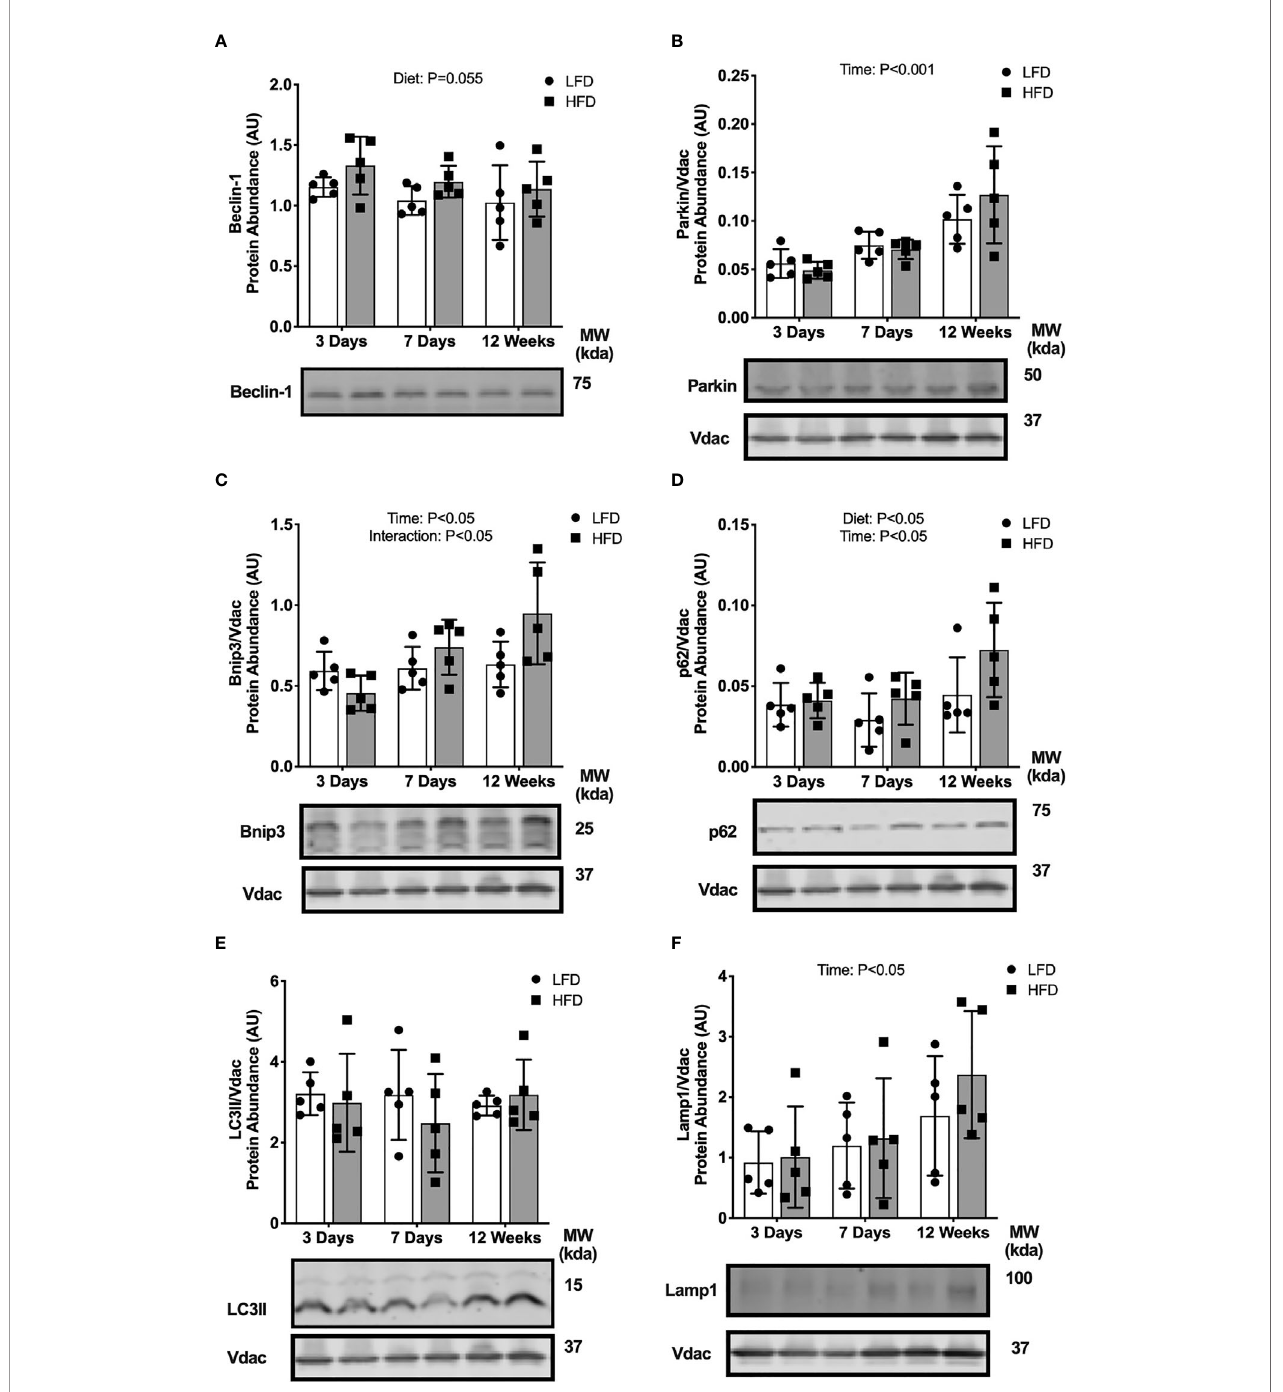
FIGURE 3 | Short-term high-fat feeding induced accumulation of mitophagy receptors. Autophagy protein markers in skeletal muscle of mice fed low-fat diet or high-fat diet for 3 days, 7 days, or 12 weeks. Quadriceps muscles were prepped as whole tissue lysates for immunoblotting of Beclin-1 (A) . Gastrocnemius muscles were fractionated to prepare a mitochondrial-enriched fraction for immunoblotting of Parkin (B) , Bnip3 (C) , p62 (D) , LC3II (E) and Lamp1 (F) . Images below graphs are representative blot images. Protein targets in the mitochondrial fraction are normalized to Vdac abundance as a mitochondrial protein control. Panels (C – E) contain the same Vdac image because the targets are from the same membrane. Data are means ± SD; n=4-5. Two-way ANOVA was used to test for effects of diet and time. P values are main